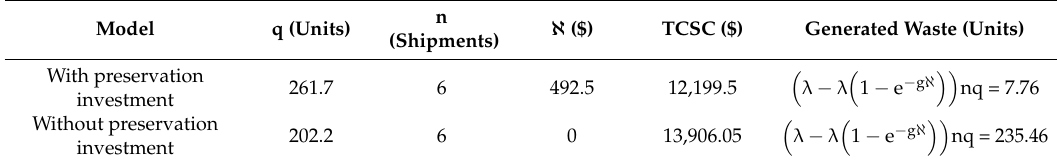
Table 1. Optimal results of case 1 and case